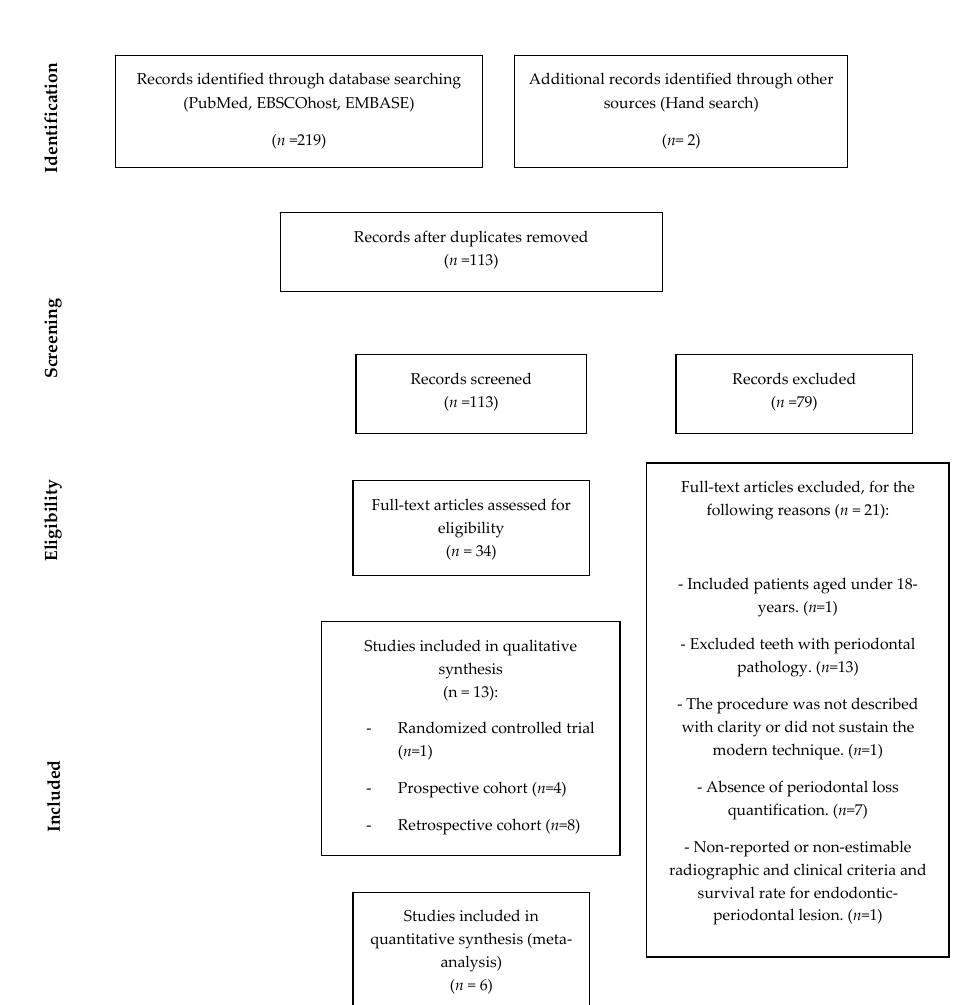
5 of 14 Figure 1. Flowchart of article selection method according to PRISMA Statement